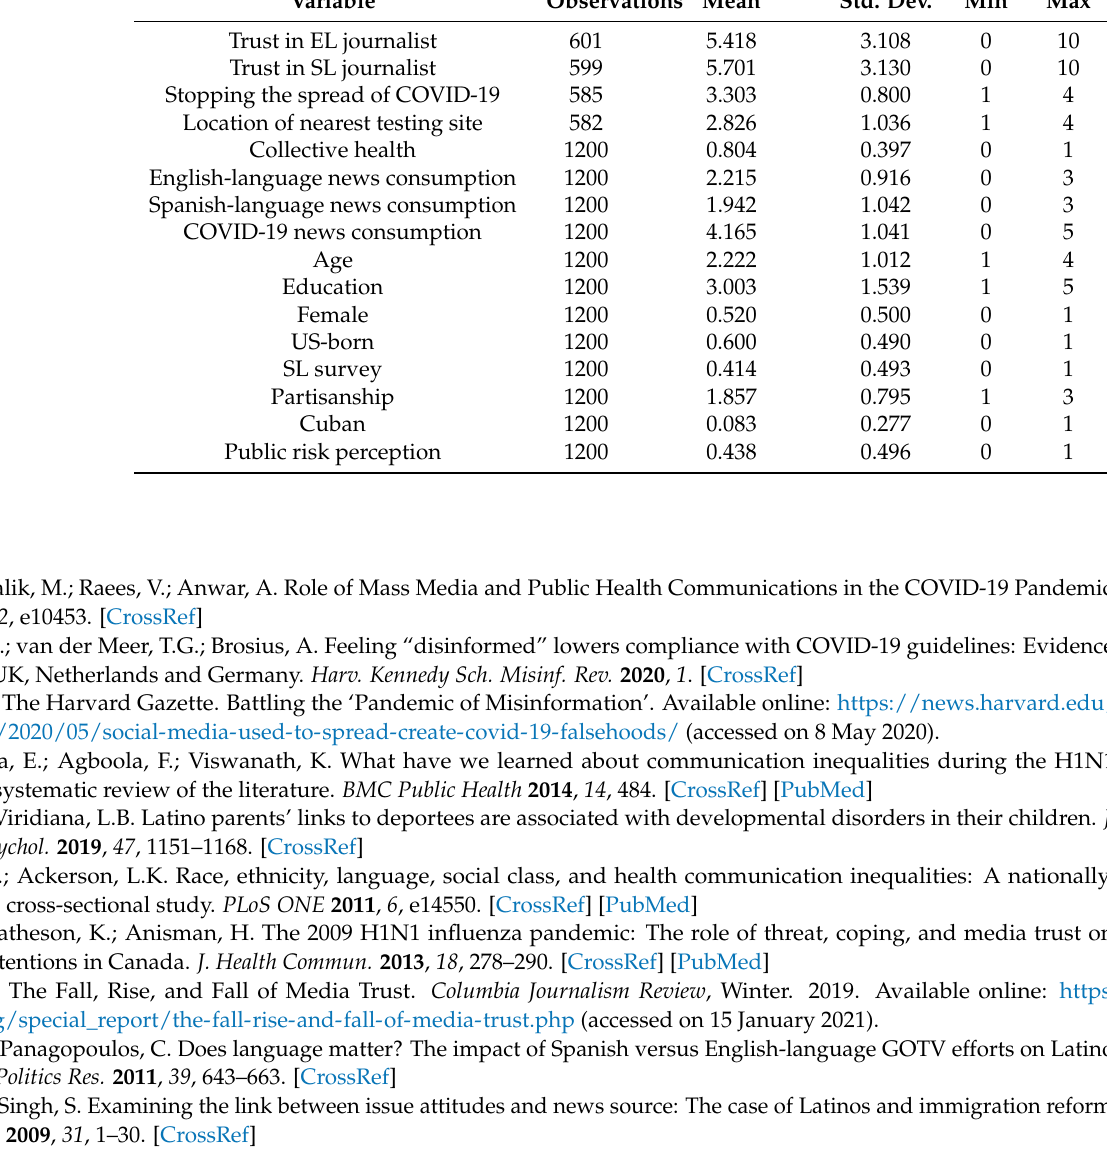
Table A1. Descriptive Statistics.